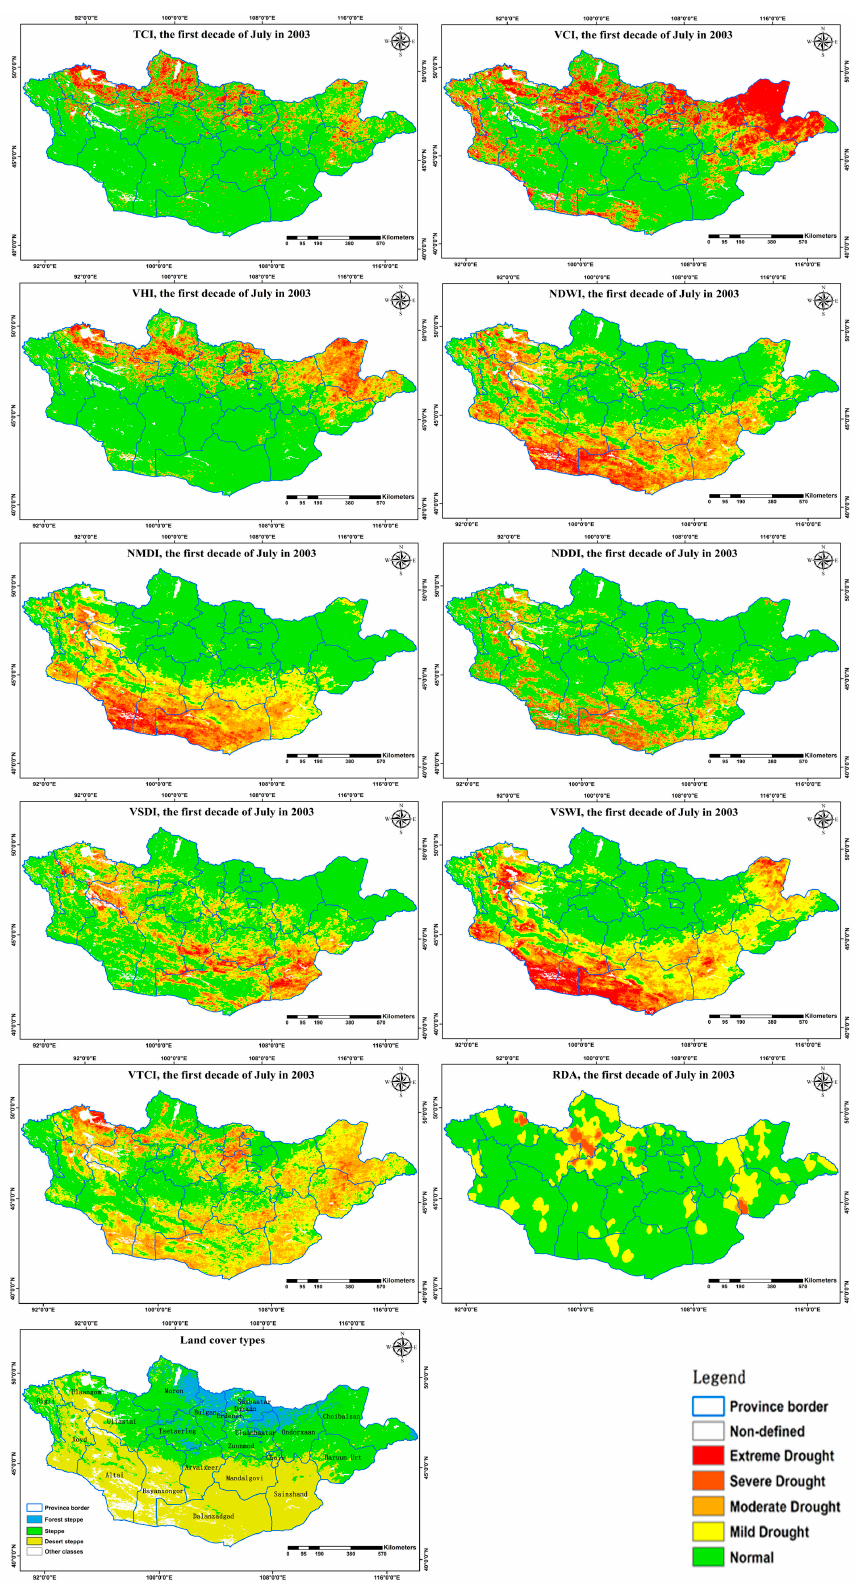
Figure 7. Spatial distribution of drought for the first 10 days of July in 2003 for the RS-derived drought indices TCI, VCI, VHI, NDWI, NMDI, NDDI, VSDI, VSWI, and VTCI as well as the RDA in three land-cover categories.